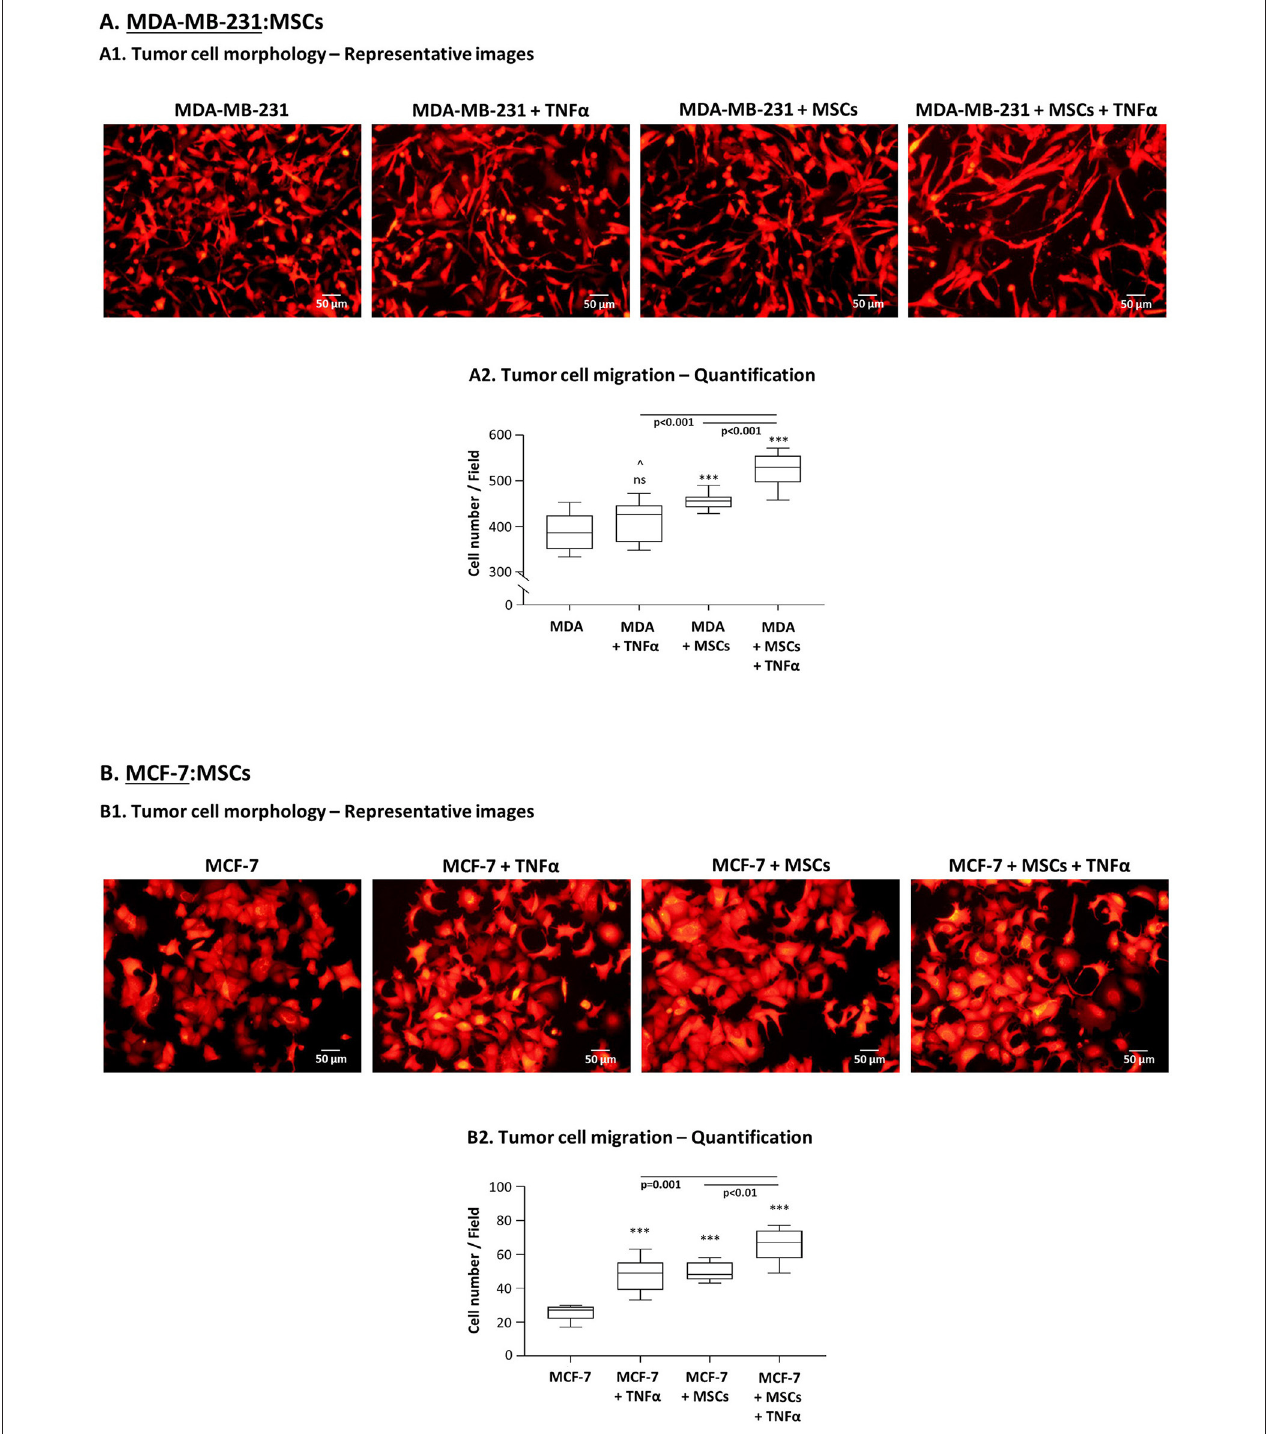
FIGURE 9 | TNBC cells, and less so luminal-A cells, acquire migration-related characteristics upon “Contact” co-culturing with MSCs in the presence of TNF α . (A) Morphology and migration phenotypes of MDA-MB-231 cells (“MDA”). (A1) Morphology of mCherry-MDA-MB-231 cells grown with MSCs in the presence of TNF α (10ng/ml), compared to tumor cells treated by vehicle, tumor cells stimulated by TNF α or tumor cells grown with MSCs only. Bar, 50 µ m. (A2) Migration of mCherry-MDA-MB-231 cells (“MDA”) grown in “Contact” co-cultures with MSCs in the presence of TNF α (10ng/ml) compared to migration of MDA-MB-231 cells treated by vehicle only, of MDA-MB-231 cells stimulated by TNF α or of MDA-MB-231 cells grown in co-culture with MSCs only. Migration assays were performed in response to medium containing 10% FBS, for 12h. *** p < 0.001, ns = non-significant for differences between migration of tumor cells in different combinations,